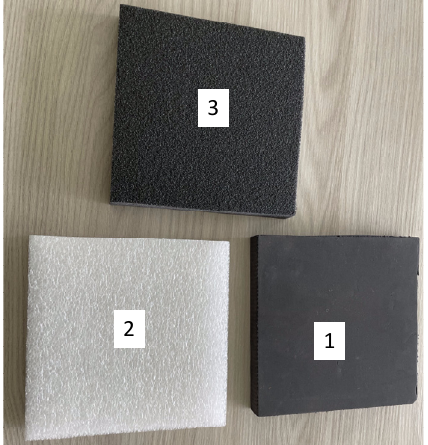
Figure 2. Foams used for this study, 1) XPE 30, 2) PE 25 and 3) PE30